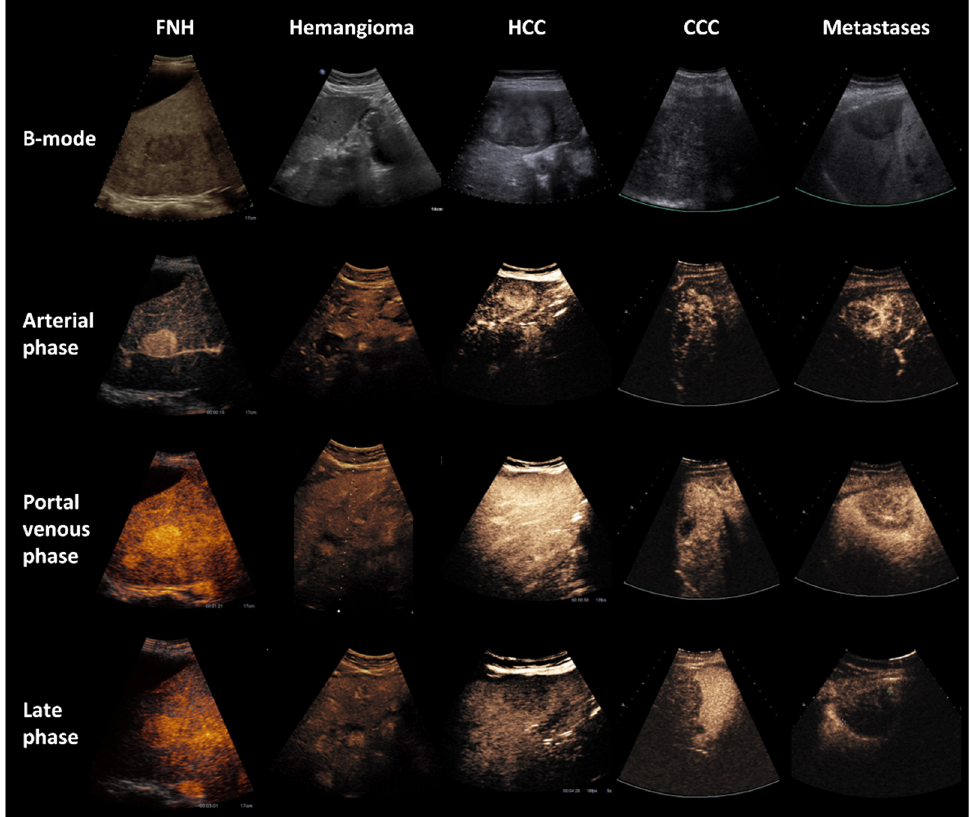
Figure 3. B-mode and CEUS of the liver in different focal liver lesions. 1st column: CEUS in a 26-year-old female with focal nodular hyperplasia (FNH); Bright hyperenhancement of contrast agent in all phases. 2nd column: CEUS in a 39-year-old male with hemangioma; Slow contrast enhancement in the arterial and portalvenous phase, approximate isoenhancement in the late phase. 3rd column: CEUS in a 51-year-old female with hepatocellular carcinoma (HCC); Bright contrast enhancement in arterial and portalvenous phase, wash-out in the late phase. 4th column: CEUS in a 42-year-old female with cholangiocellular carcinoma (CCC); Contrast enhancement in arterial and portalvenous phase, wash-out in the late phase. 5th column: CEUS in a 54-year-old female with liver metastases of breast cancer; Contrast enhancement in the arterial phase, wash-out with beginning in the portalvenous